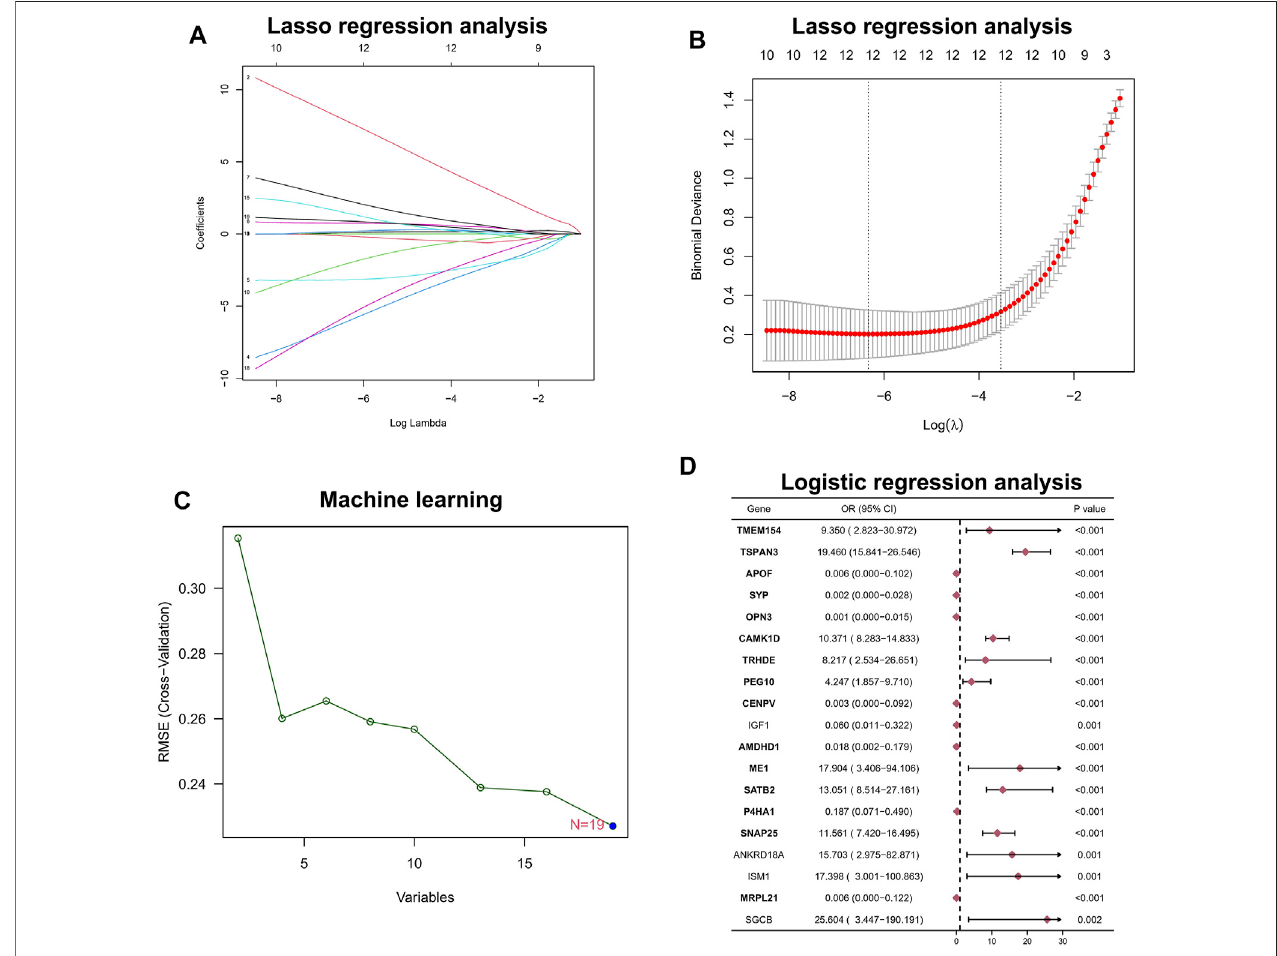
FIGURE 2 | Hub biomarker screening. (A,B) LASSO regression analysis. (C) Machine learning approach with SVM. (D) Logistic regression analysis.